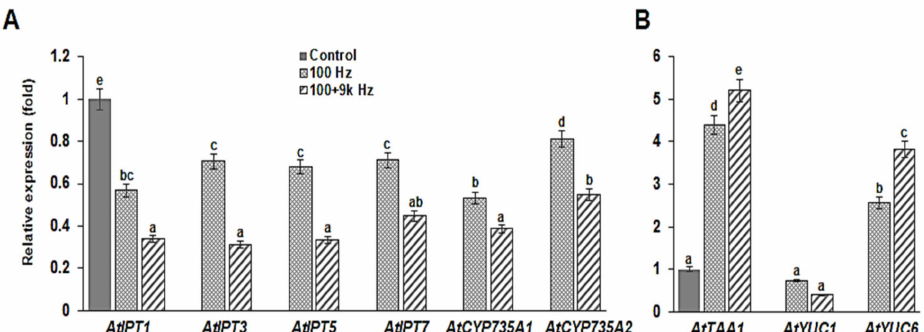
Figure 5. Effect of sound wave treatments on the expression of genes related to cytokinin (CK) and auxin biosynthesis in Arabidopsis roots. ( A ) Expression of CK biosynthesis-related genes after sound wave treatments, as determined by qRT-PCR. ( B ) Expression of auxin biosynthesis-related genes after sound wave treatments, as determined by qRT-PCR. Values were normalized to the value of the control. Error bars indicate the standard error of the mean of three biological replicates. Different letters above the bars indicate significantly different mean values ( p < 0.05) based on Duncan’s multiple range